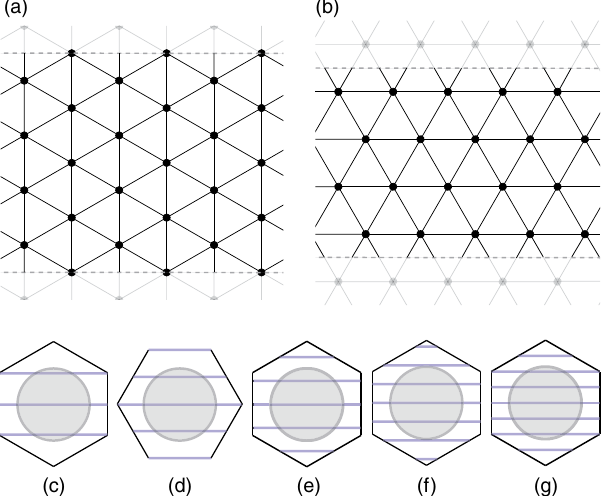
FIG. 1. (a) Triangular lattice on a cylinder of circumference 4 with YC boundary conditions (YC4 cylinder); the dashed lines are identified together and run along the length of the cylinder. (b) XC4 cylinder. (c) – (g) Horizontal lines show allowed momenta in the Brillouin zone for the YC3, XC4, YC4, YC5, and YC6 cylinders, in order of increasing circumference. The shaded circle shows the Fermi surface for noninteracting electrons ( U ¼ 0